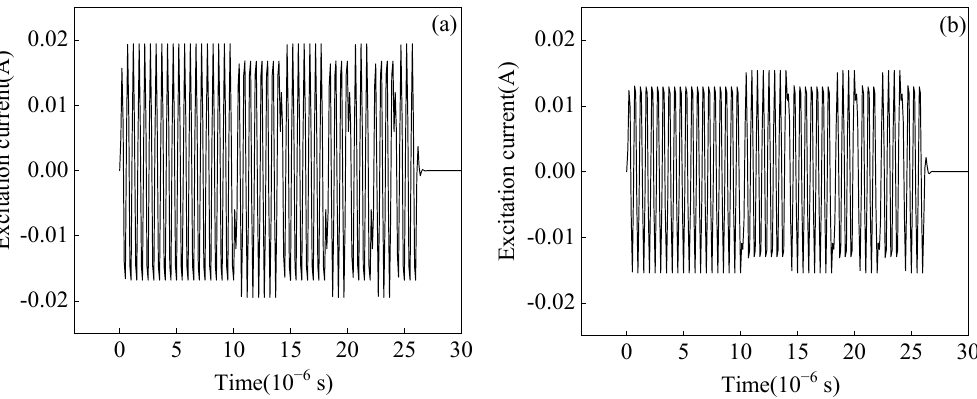
Figure 20. Excitation current calculated by EMAT excitation equivalent circuit with ( a ) Impedance matching method I ( b ) Impedance matching method II.